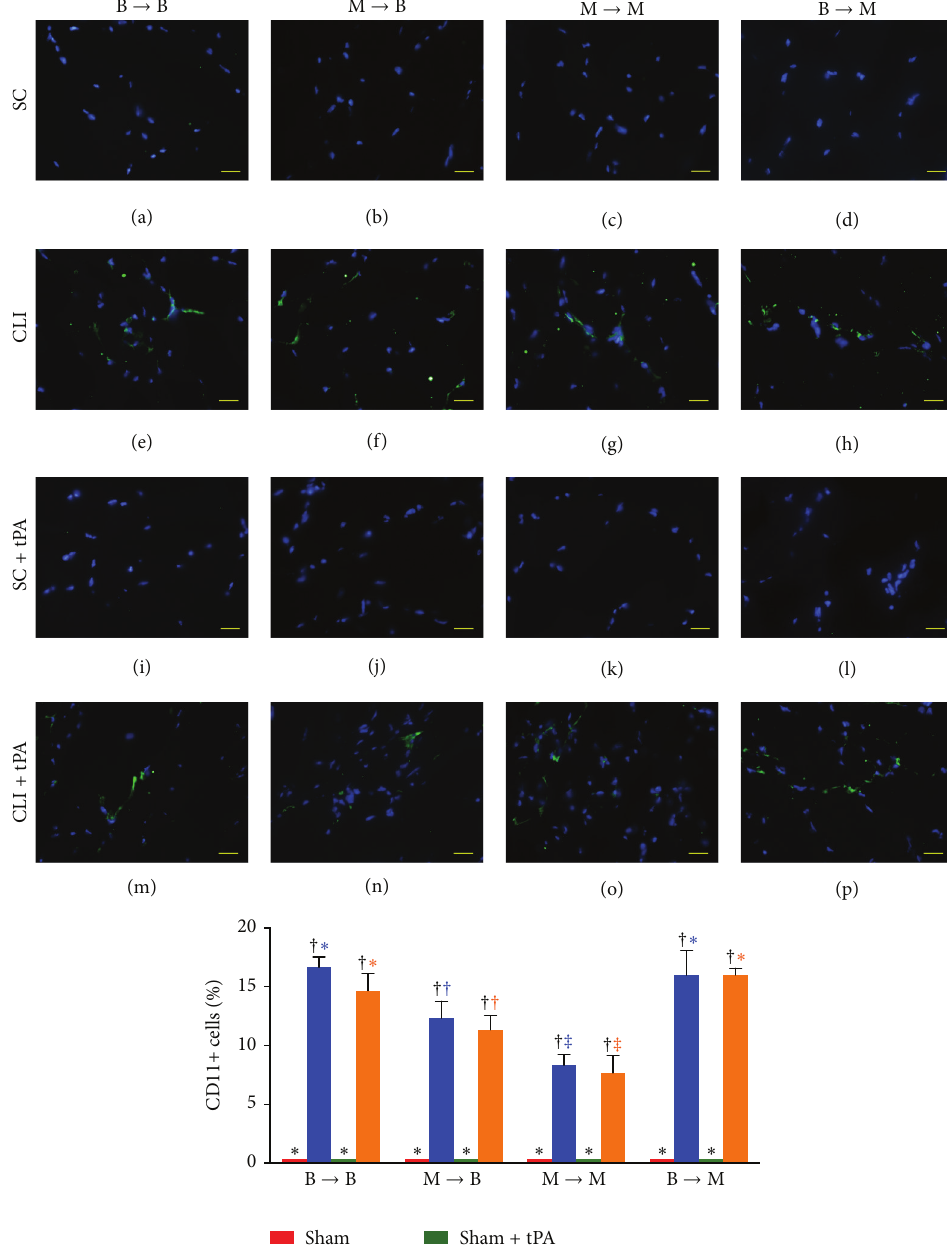
Figure 13: Immunofluorescent (IF) microscopic findings (400x) of neutrophils (CD11+ cells) in ischemic quadriceps at day 14 after critical limb ischemia (CLI) induction. (a–p) IF microscopic findings of neutrophils in ischemic area in four treatment conditions of four groups. (1) Statistical analysis for subgroups of each group. (1) In B → B group, subgroups with different black symbols ( ∗ , † ), 𝑝 < 0.05 . (2) In M → B group, subgroups with different black symbols ( ∗ , † ), 𝑝 < 0.05 . (3) In M → M group, subgroups with different black symbols ( ∗ , † ), 𝑝 < 0.05 . (4) In B → M group, subgroups with different black symbols ( ∗ , † ), 𝑝 < 0.05 . (2) Statistical analysis for group comparison with respective treatment condition. (1) In SC subgroup (red bar chart), 𝑝 > 0.05 . (2) In CLI subgroup (blue bar chart), groups with different blue symbols ( ∗ , † , and ‡ ), 𝑝 < 0.05 . (3) In SC + tPA subgroup (green bar chart), 𝑝 > 0.05 . (4) In CLI + tPA subgroup (orange bar chart), groups with different orange symbols ( ∗ , † , and ‡ ), 𝑝 < 0.05 . All statistical analyses were performed by one-way ANOVA followed by Bonferroni multiple comparison post hoc test. SC = sham control; tPA = tissue plasminogen activator. 𝑛 = 6 for each